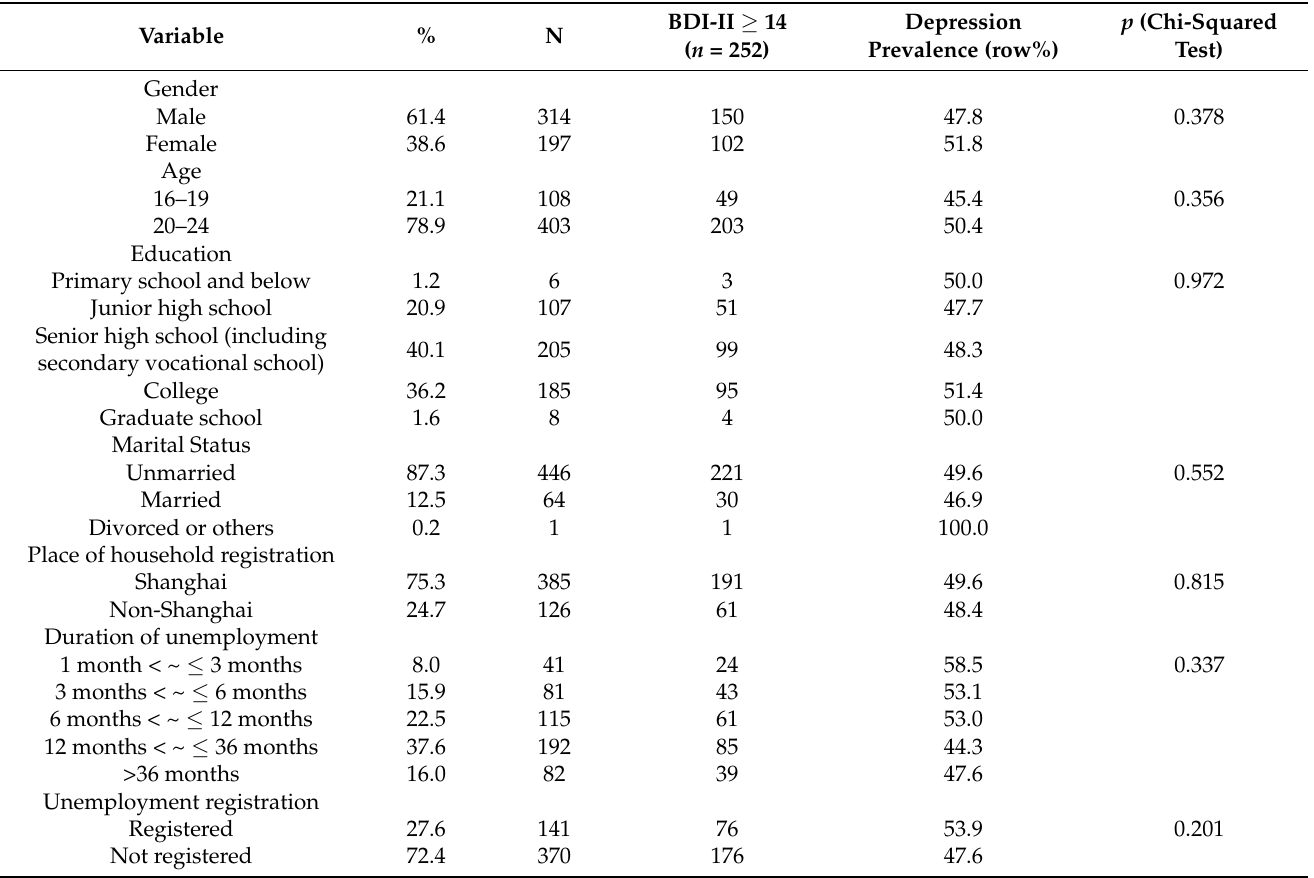
Table 1. Description of sample demographics and the results of chi-squared tests (N =